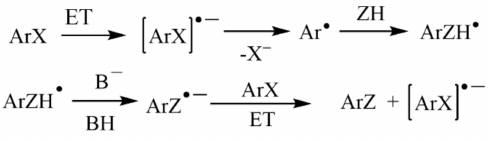
Figure 19. The mechanism of base-promoted homolytic aromatic substitutions. Reprinted with permission from Ref. [69]. Copyright 2013, American Chemical Society.